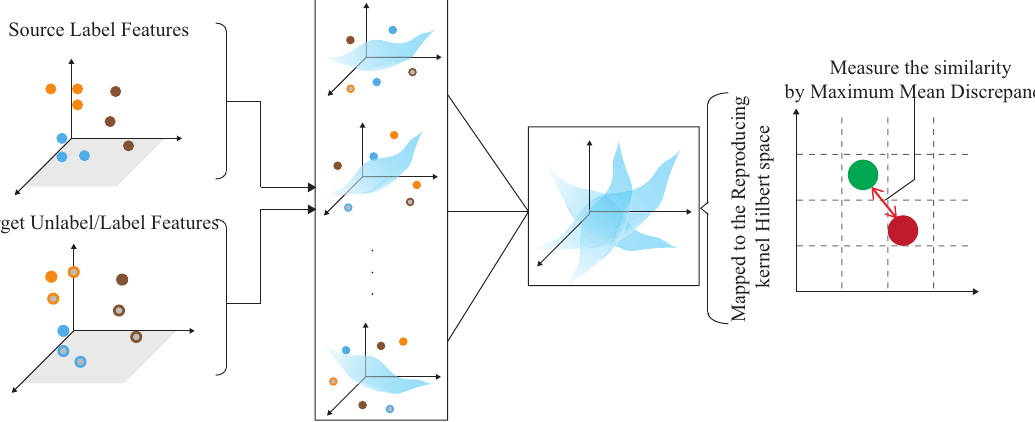
Figure 5. Transfer learning with minimized multiple